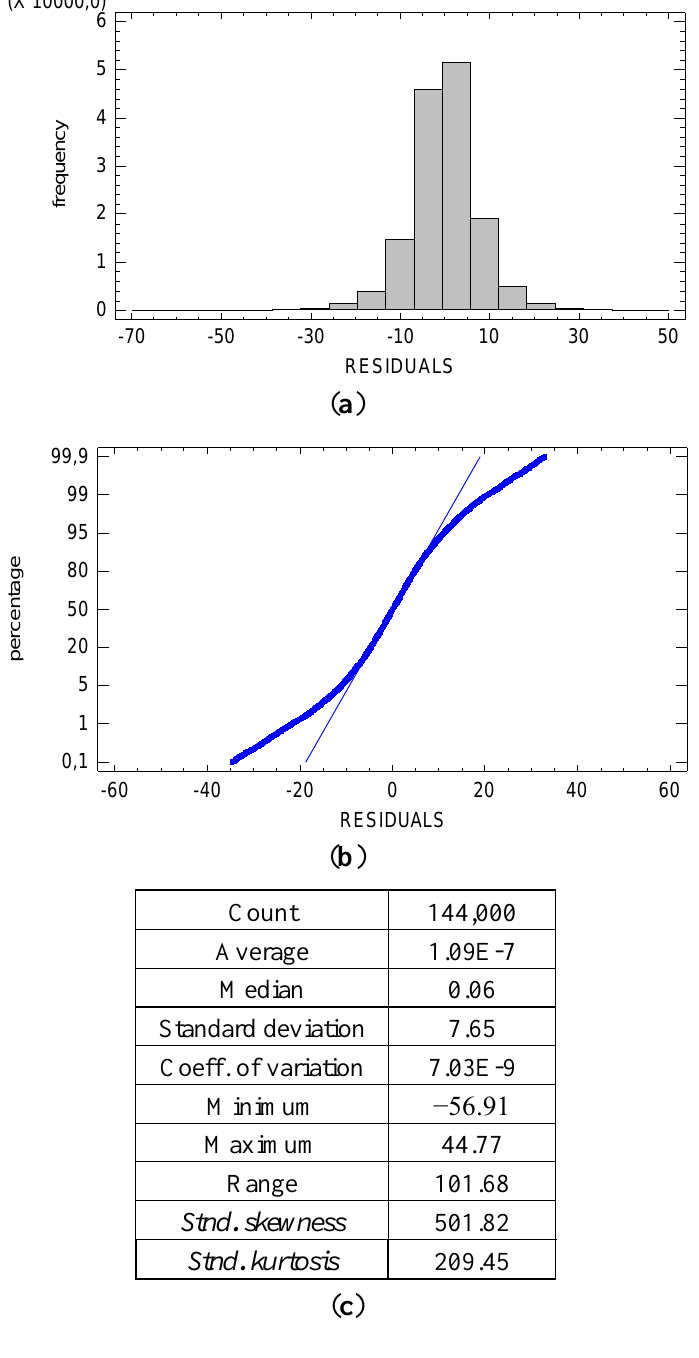
Figure 5. Descriptive statistics and plots for the totality of the residuals. ( a ) The histogram of the residuals; ( b ) The normal probability plot for the residuals illustrates the slight failing of the normal distribution; ( c ) The skewness and kurtosis coefficients indicate the slight fail of the normal